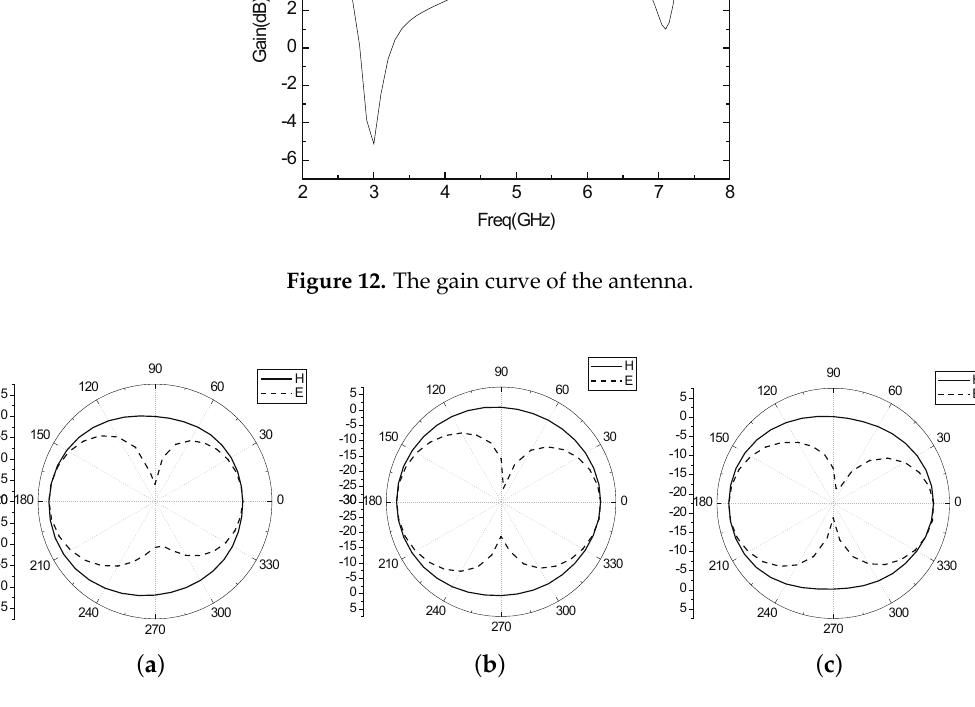
Figure 13. Antenna pattern ( a ) 2.45 GHz; ( b ) 5.2 GHz; ( c ) 5.8